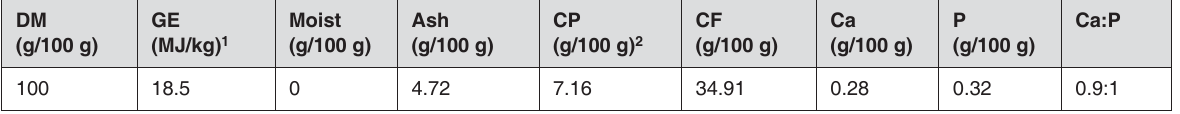
TABLE 1 Eragrostis tef hay fed to the sheep throughout the trial. All values are on a DM